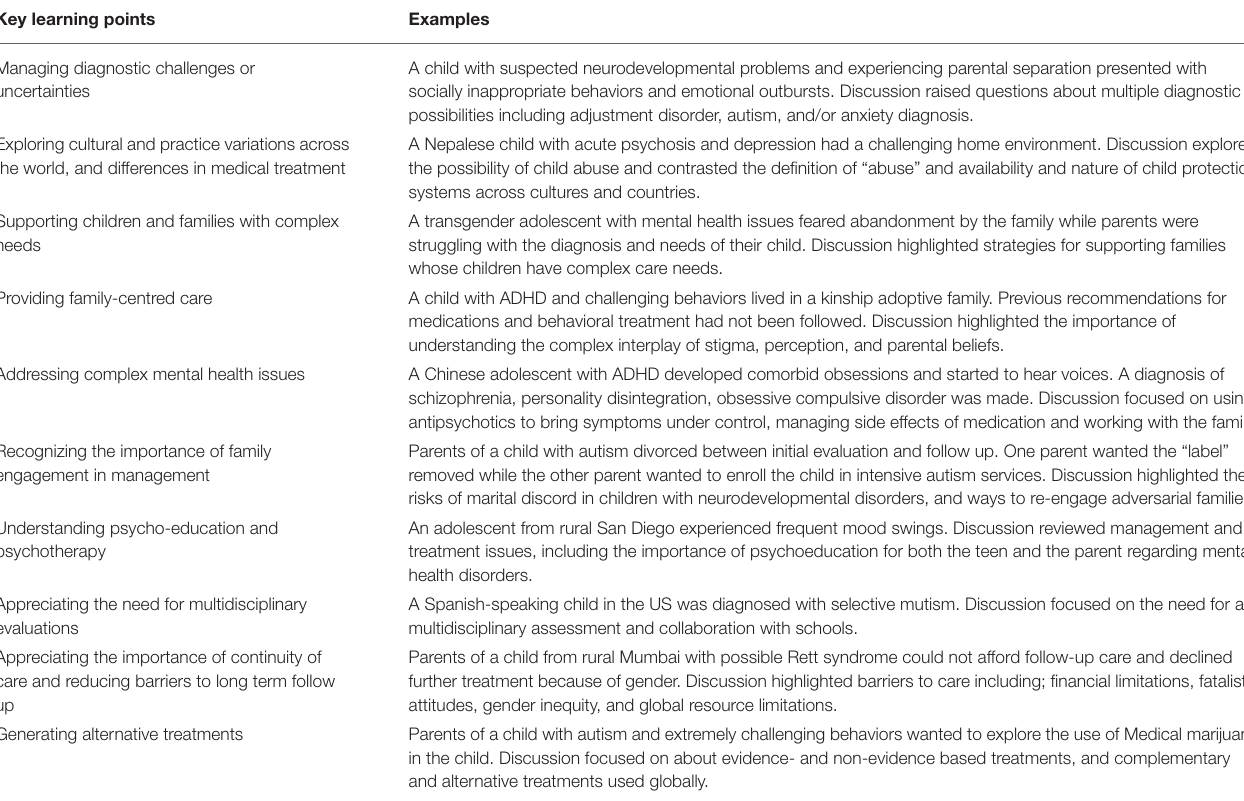
TABLE 3 | Learners’ self-descriptions of the key learning points of the sessions and their related case